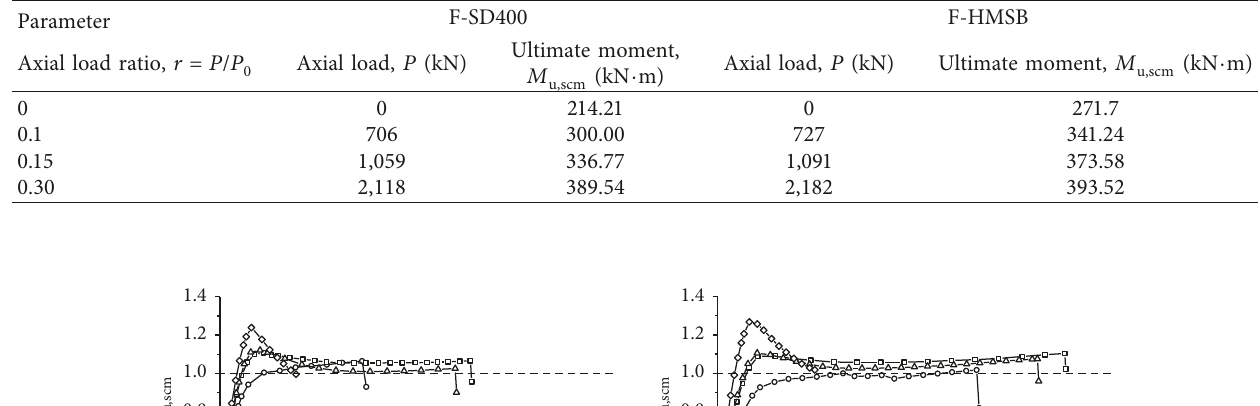
Table 5: Axial load ratios and corresponding theoretical moment capacity.